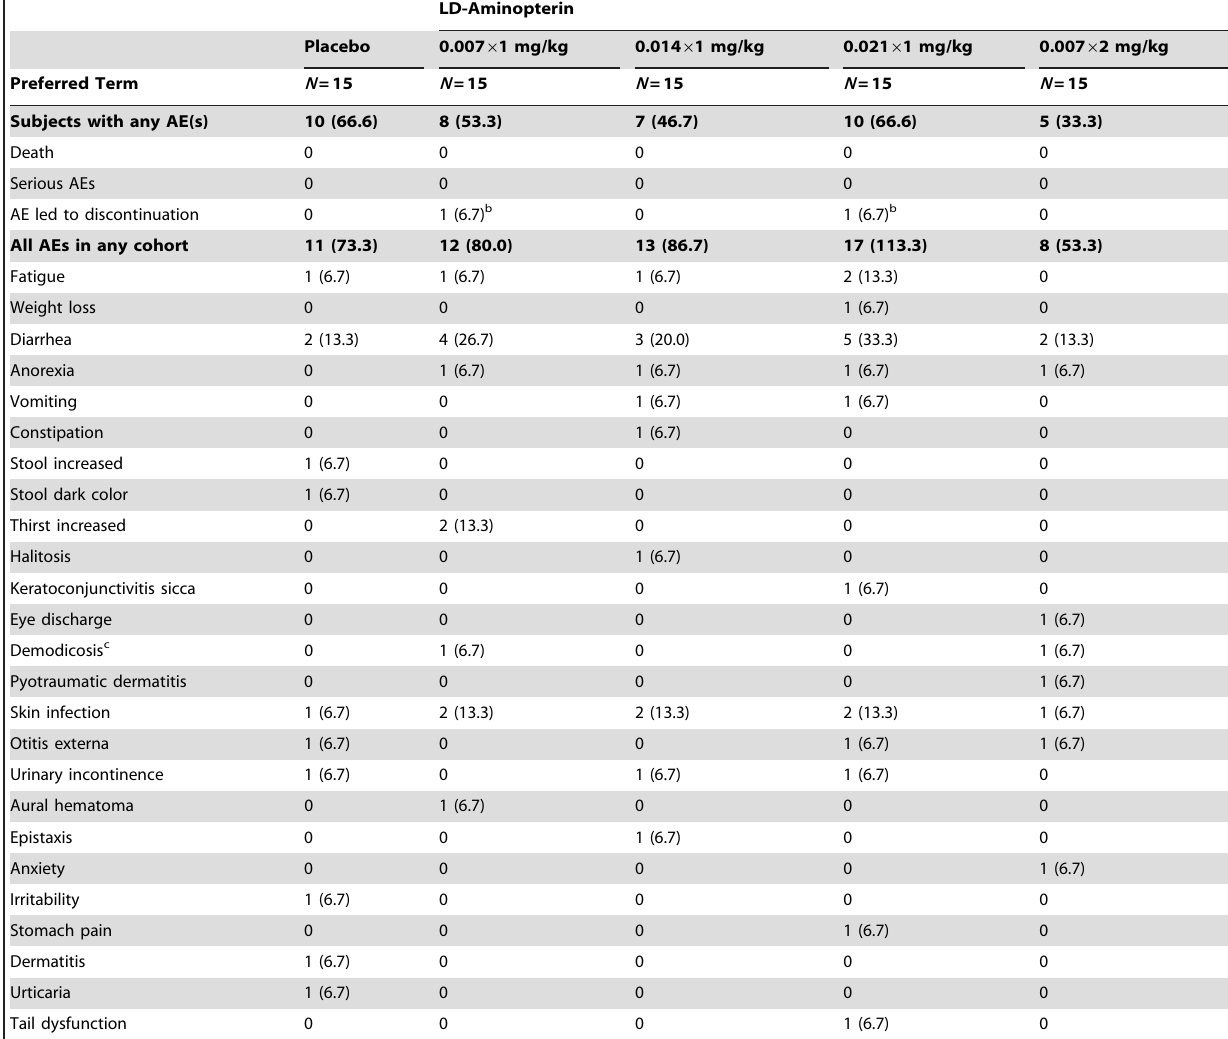
Table 3. Summary of clinical AEs by cohort a